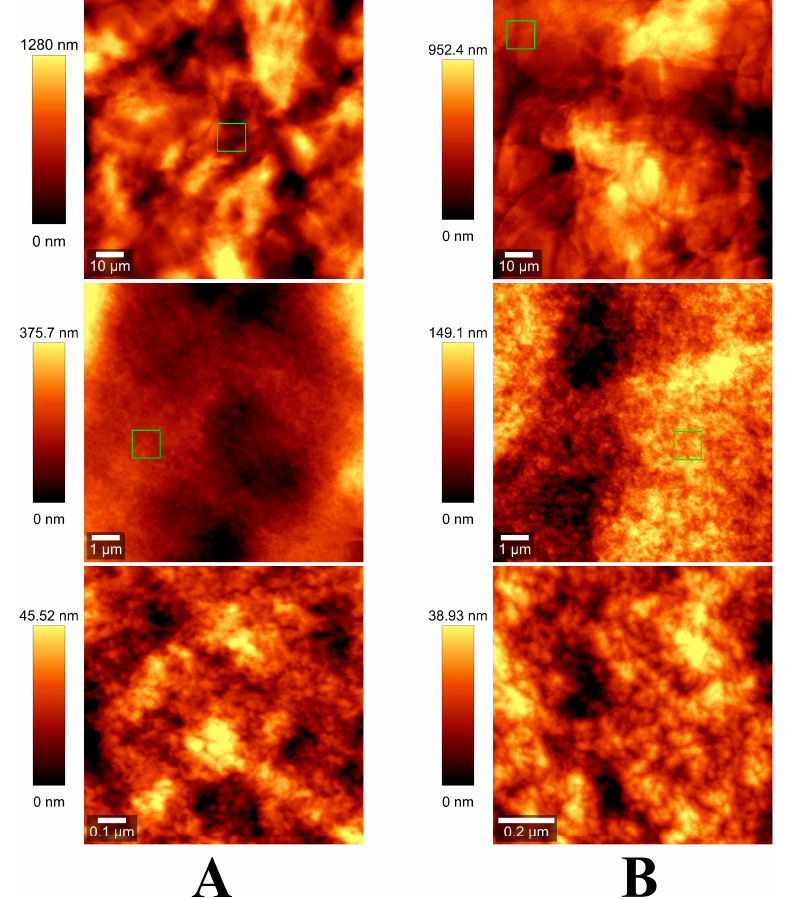
Figure 2. AFM surface topography scan of nickel (II) alginate ( A ) and cobalt (II) alginate ( B ). From top to bottom: 100 µm × 100 µm, 10 µm × 10 µm and 1 µm × 1 µm scans. Green square represents an area scanned at a higher resolution.